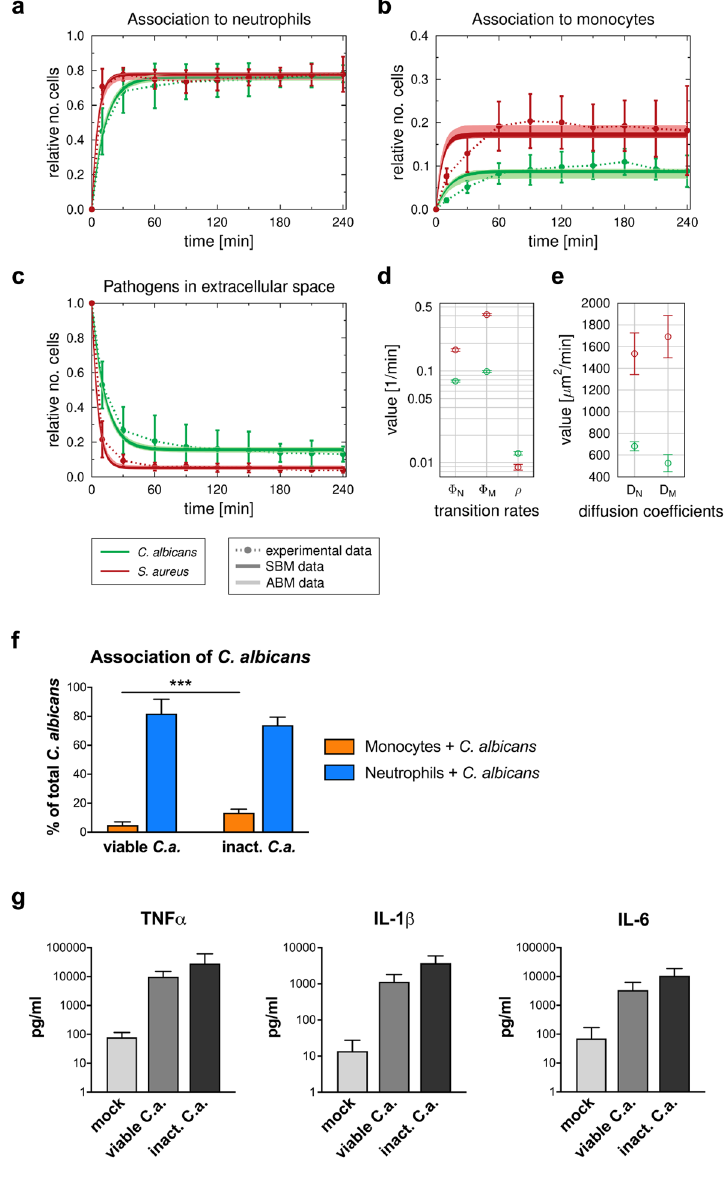
Figure 1. Comparison of the dynamics of host–pathogen interaction during C. albicans and S. aureus infection in healthy blood. ( a – c ) Results of fitting the state-based model (SBM) and the agent-based model (ABM) to experimental data. Simulated dynamics of the combined units (solid line) were obtained by fitting the SBM (dark color) and the ABM (light color) to the experimentally measured association kinetics (dotted line). Experimental data were gained from whole-blood infection assays with either C. albicans (green, n = 10) or S. aureus (red, n = 7). SBM: line thickness represents SD obtained by 50 simulations with transition rate values sampled within their corresponding SD. ABM: line thickness represents the standard deviations obtained from 30 stochastic simulations with the estimated diffusion coefficients. ( a ) and ( b ), dynamics of the combined units P N and P M , which correspond to the experimental data on pathogens associated with neutrophils and monocytes. ( c ) kinetics of the combined unit P E together with experimentally measured kinetics of either fungal or bacterial cells in extracellular space. ( d ) Mean values (± SD) of transition rate values obtained by fitting the SBM to experimental data using simulated annealing. The rate of phagocytosis by neutrophils ( φ N ) and by monocytes ( φ M ) as well as the rate for immune escape ( ρ ) are depicted for infection scenarios with either C. albicans (green circle) or S. aureus (red circle). (e) Diffusion coefficients for neutrophils ( D N ) and monocytes ( D M ) were estimated by fitting the ABM to the experimental data for C. albicans (green circle) and S. aureus (red circle), respectively. Mean and SD are calculated from all parameter sets with a mean LSE within the SD of the optimal parameter set. ( f ) Association of viable and inactivated C. albicans with blood monocytes and neutrophils after 60 min quantified using flow cytometry. Significance was estimated using the unpaired, two-sided Student t test (*** P < 0.001). ( g ) Release of monocyte-derived cytokines (TNF-α, IL-1β, IL-6) in plasma samples generated from 4 h whole-blood infection experiments in response to viable and inactivated C. albicans cells was investigated. Bars are shown as means ± SD of at least 3 independent experiments with whole blood from different